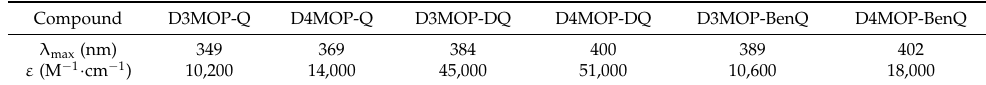
Table 10. Optical characteristics of the different MOPQs in chloroform.